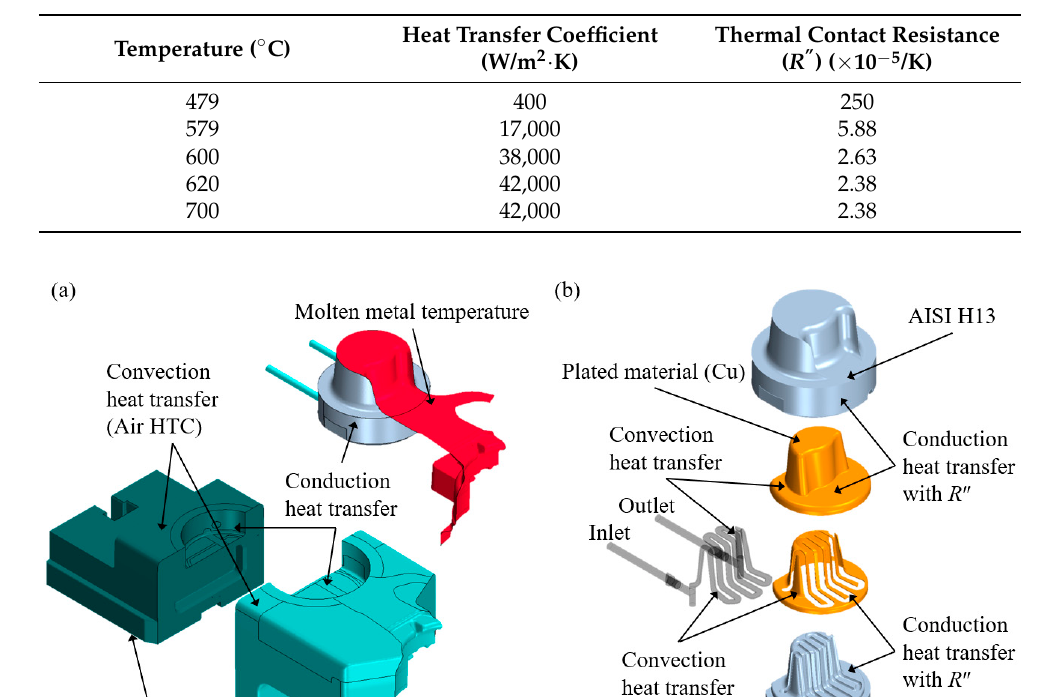
Table 3. The heat transfer coefficients and the thermal contact resistance considering solid and liquid cast temperatures.